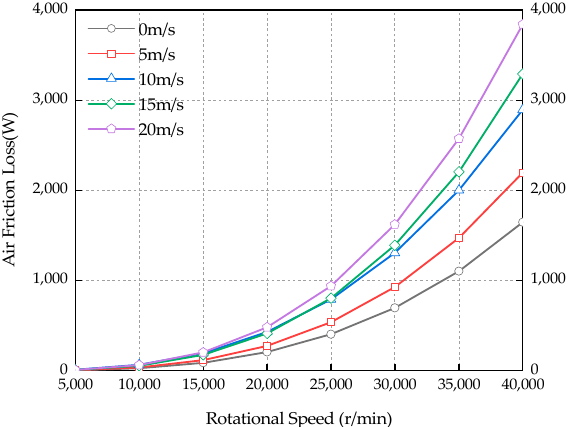
Figure 12. Air-friction loss calculation with rotor at different speed by Figure 12. Air ‐ friction loss calculation with rotor at different speed by FE.